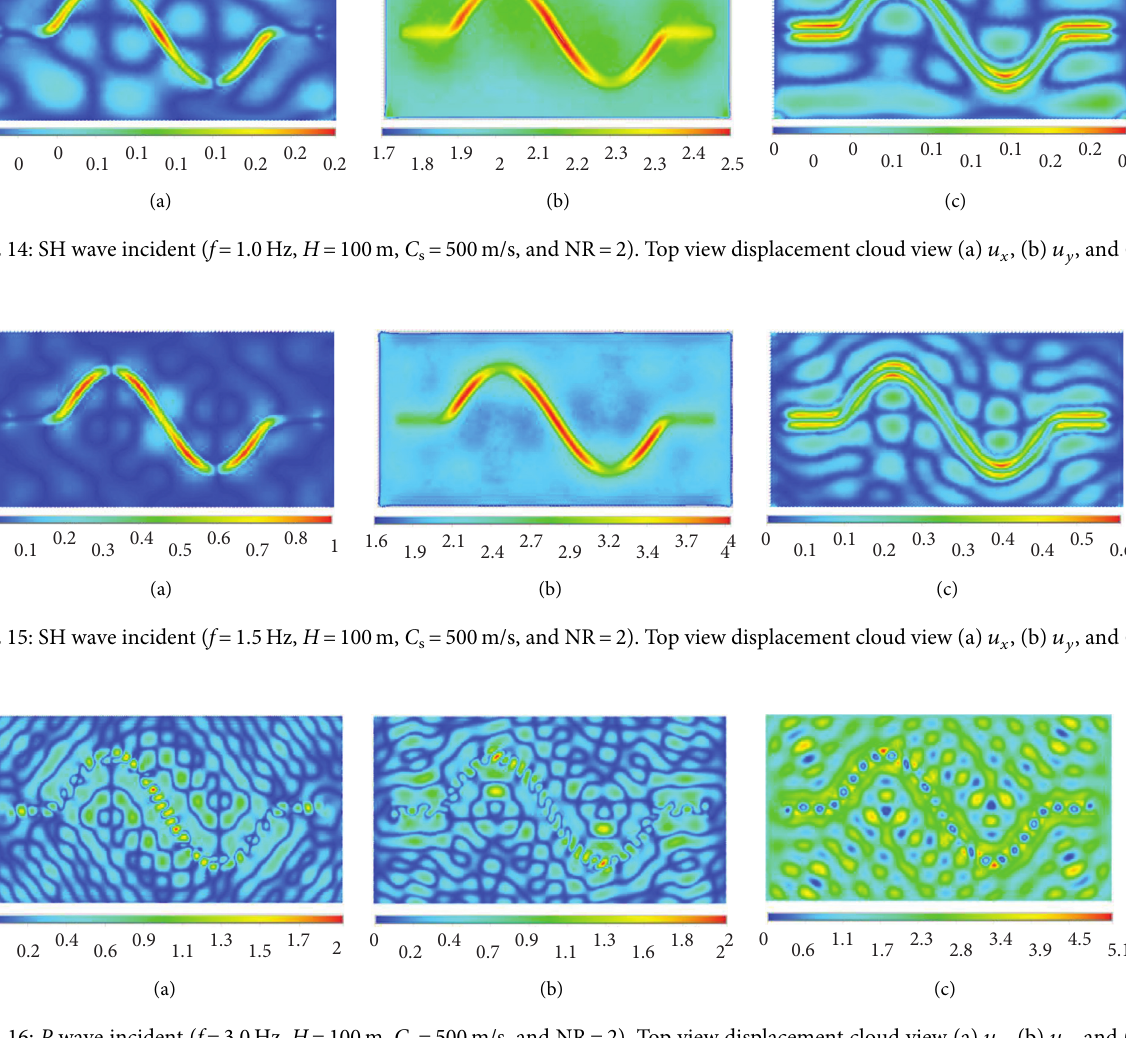
� 500m/s, and NR � 2). Top view displacement cloud view (a) u s